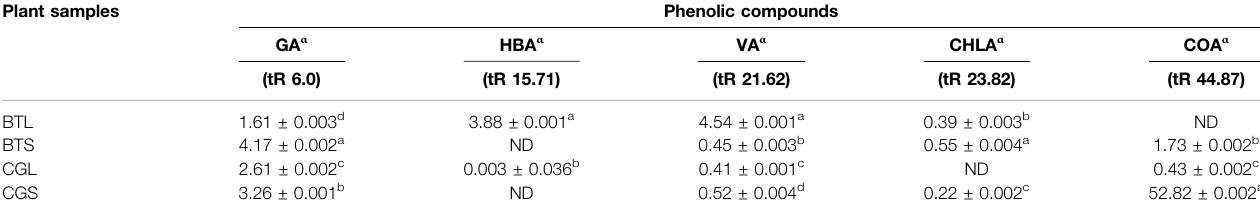
Table 1 . Among all the samples, Calacanthus grandi fl orus leaves